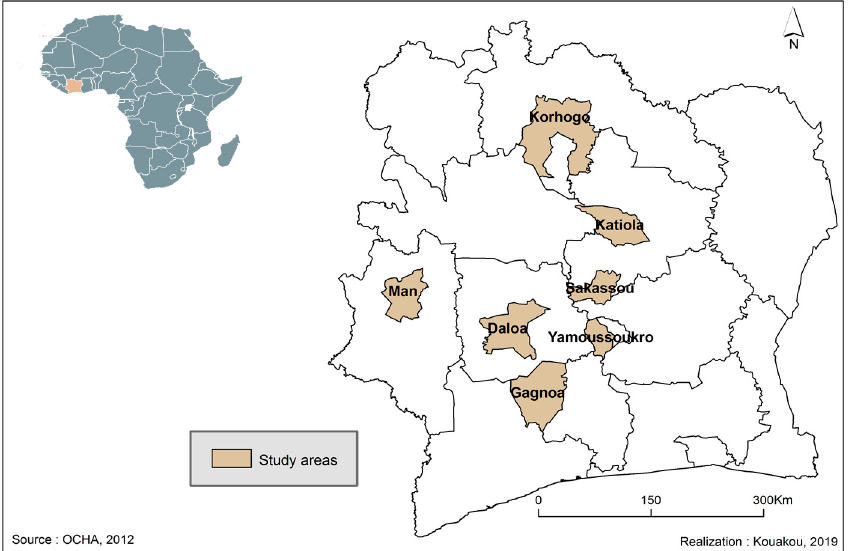
Figure 2. Map of the study area.